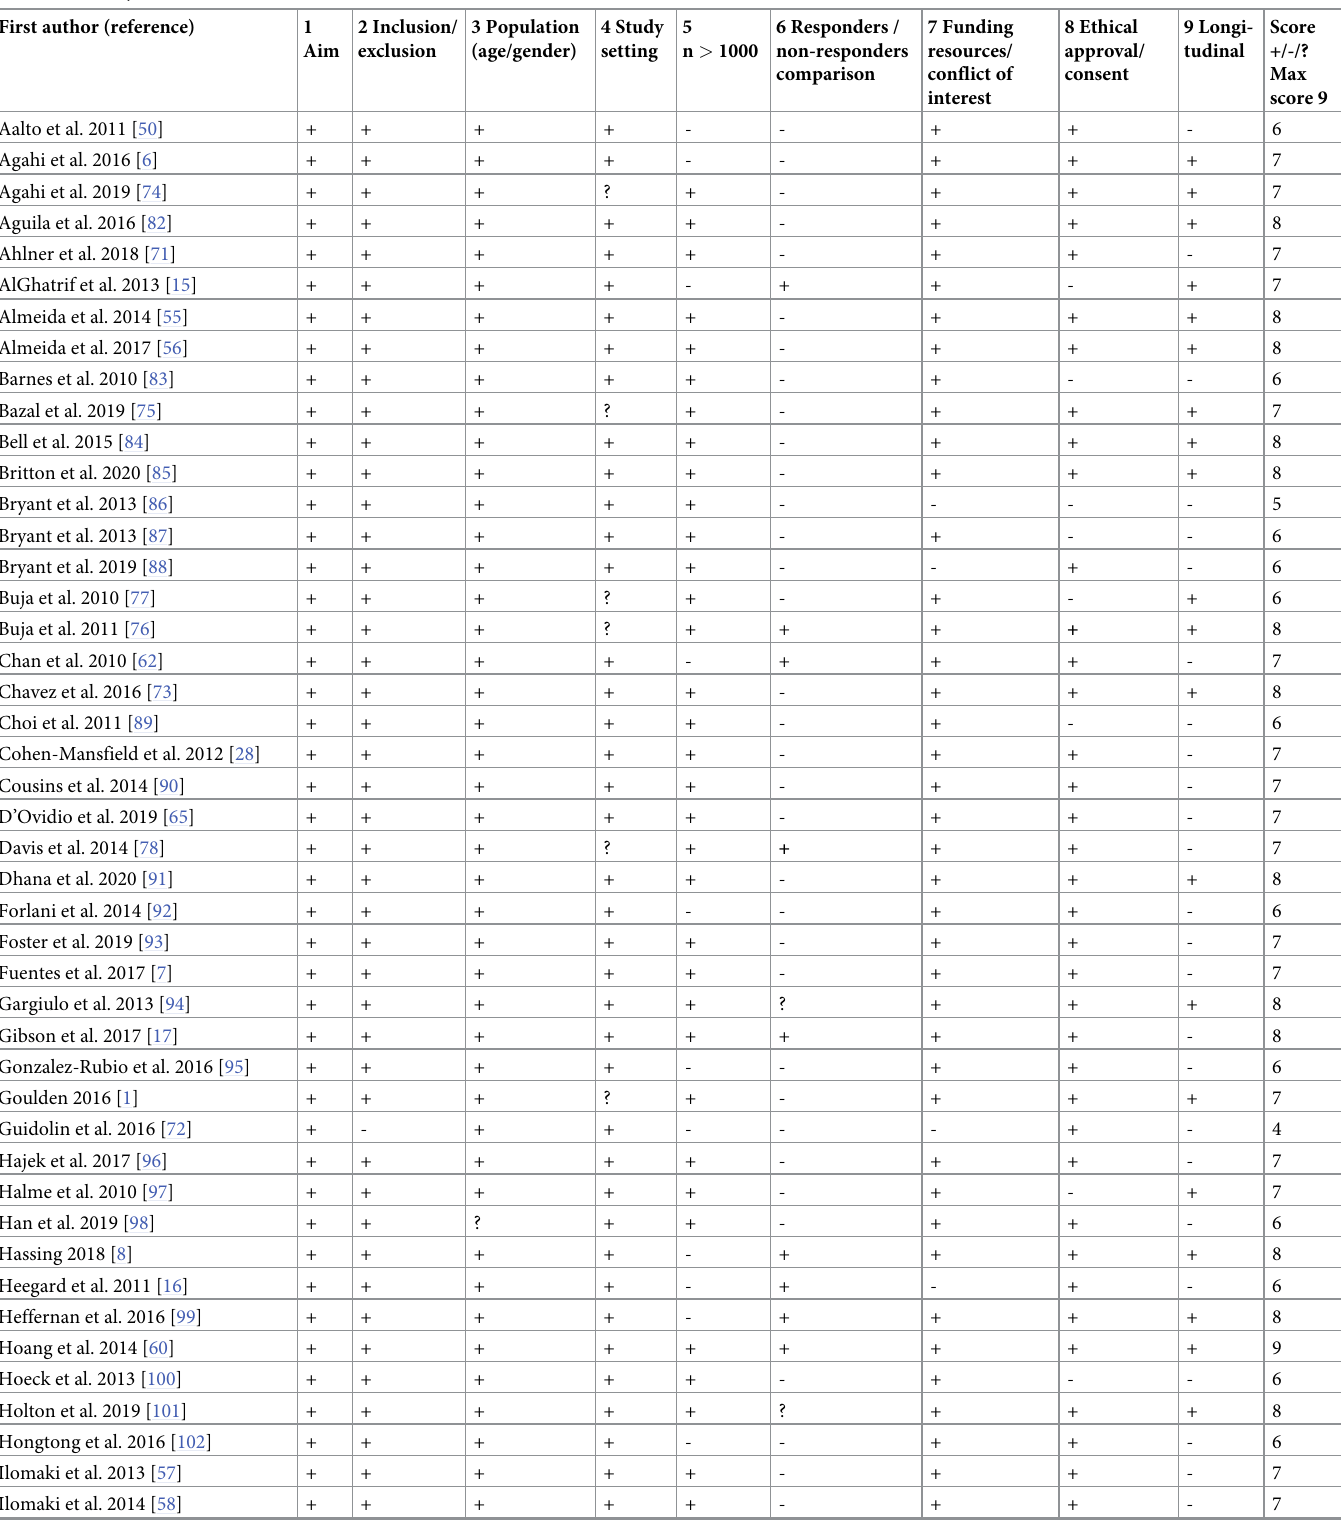
Table 2. Quality assessment of included